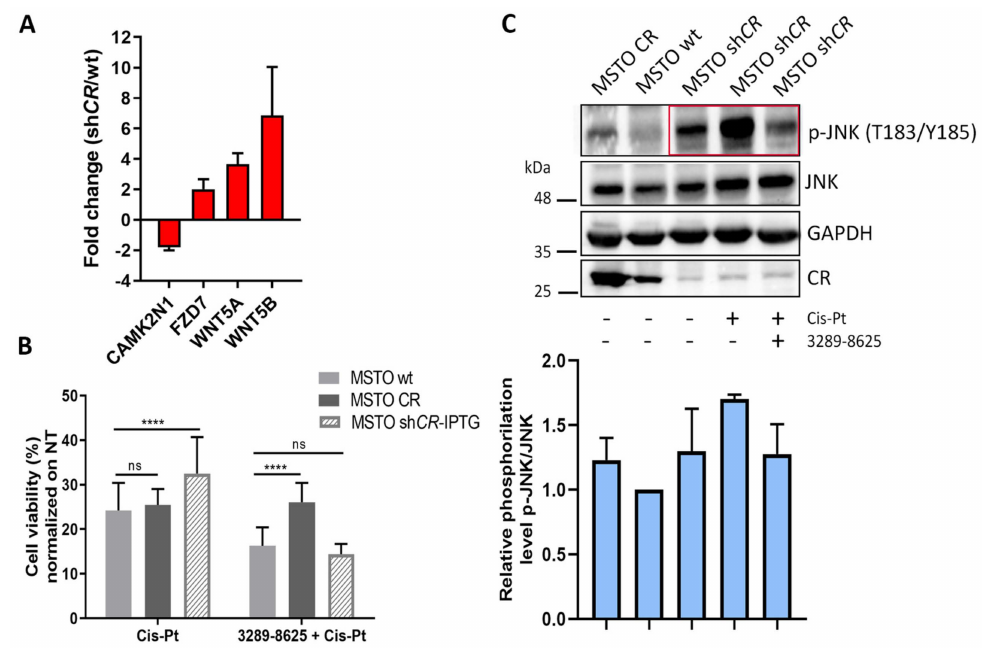
Figure 4. E ff ect of Cis-Pt and 3289-8625 on cell viability of MSTO-wt, MSTO-CR and MSTO-shCALB2-IPTG (induced) cells. ( A ) Relative fold-change of transcript expression determined by a PCR array in MSTO-shCALB2-IPTG (induced) cells compared to MSTO-wt cells. In CR-depleted cells note upregulation of gene transcripts related with the Wnt-signaling pathway ( FZD7 , WNT5A and WNT5B ) and a decrease in the CaMKII inhibitor CAMK2N1 . ( B ) MTT signals of MSTO-wt, MSTO-CR and shCALB2-IPTG (induced) cells after treatment (72 h) with Cis-Pt alone (left bars) or the combination (right bars) of the Wnt-pathway inhibitor 3289-8625 for 24 h (100 µ M), followed by additional 48 h in the presence of Cis-Pt (2.5 µ M; n = 5 independent experiments; asterisks represent **** p ≤ 0.0001). ( C ) Upper part: Representative Western blot signals of p-JNK (Thr 183 / Tyr 185 ), JNK, and CR levels in untreated (CR-overexpressing) MSTO-CR, control MSTO-wt, and CR-depleted MSTO-shCALB2-IPTG (induced) cells, in MSTO-shCALB2-IPTG (induced) cells treated with Cis-Pt (5 µ M) for 72 h alone, or pre-treated for 24 h with the Wnt inhibitor 3289-8625 (100 µ M) followed by 48 h treatment of Cis-Pt (5 µ M). The most pertinent signals for p-JNK (Thr 183 / Tyr 185 ) are boxed in red. GAPDH was used as loading control. Lower part: Quantification of the relative JNK phosphorylation levels (ratio p-JNK / JNK normalized to GAPDH; ratio for MSTO-wt signals defined as 1.0) is shown ( n = 3 independent experiments; mean ± SD). In CR-depleted (MSTO-shCR) cells, Cis-Pt treatment increases p-JNK (Thr 183 / Tyr 185 ) (upper panel in C ) and the ratio p-JNK / JNK, an e ff ect that is reversed by the Wnt signaling inhibitor